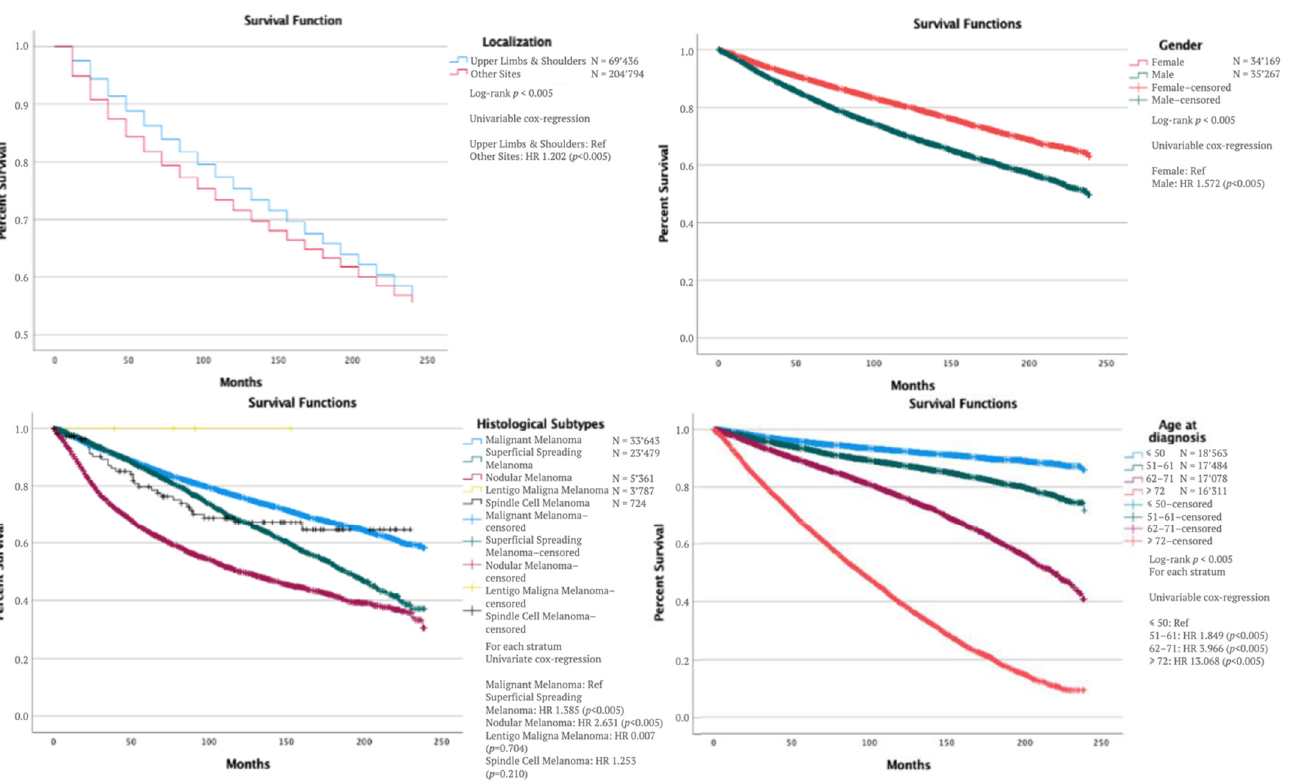
Figure 3. Overall survival according to the primary site, gender, histological subtypes, and age at diagnosis for upper limbs and shoulders melanoma.